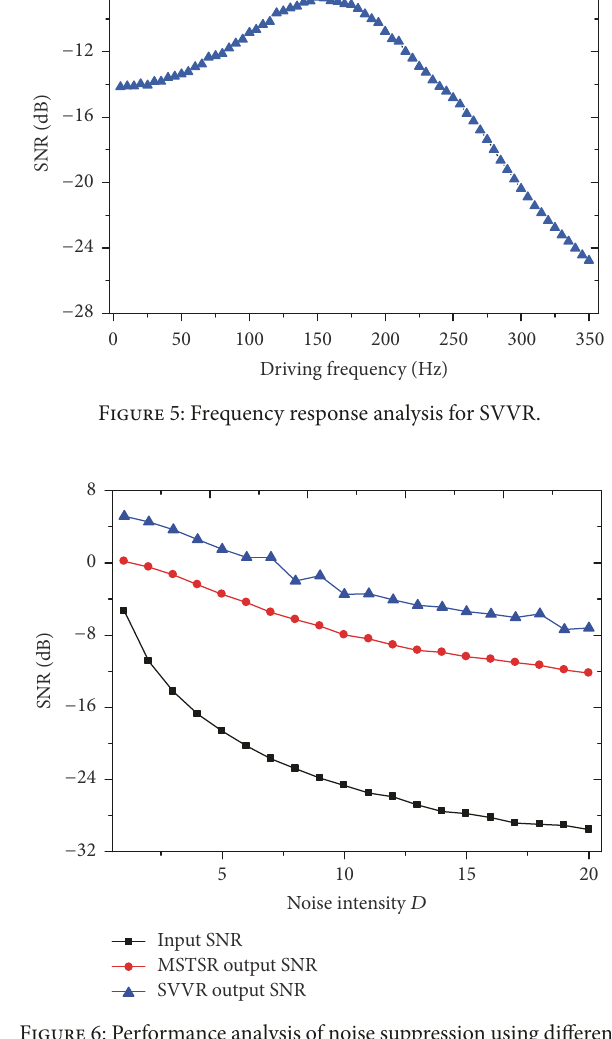
Figure 6: Performance analysis of noise suppression using different WSD methods.